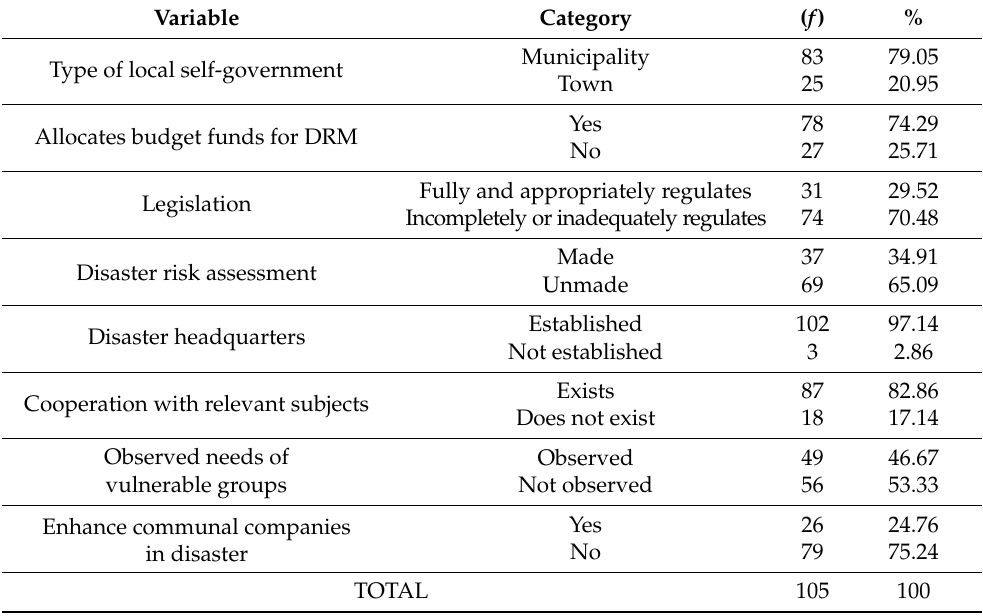
Table 1. Overview of the basic characteristics of local self-governments ( n = 105).